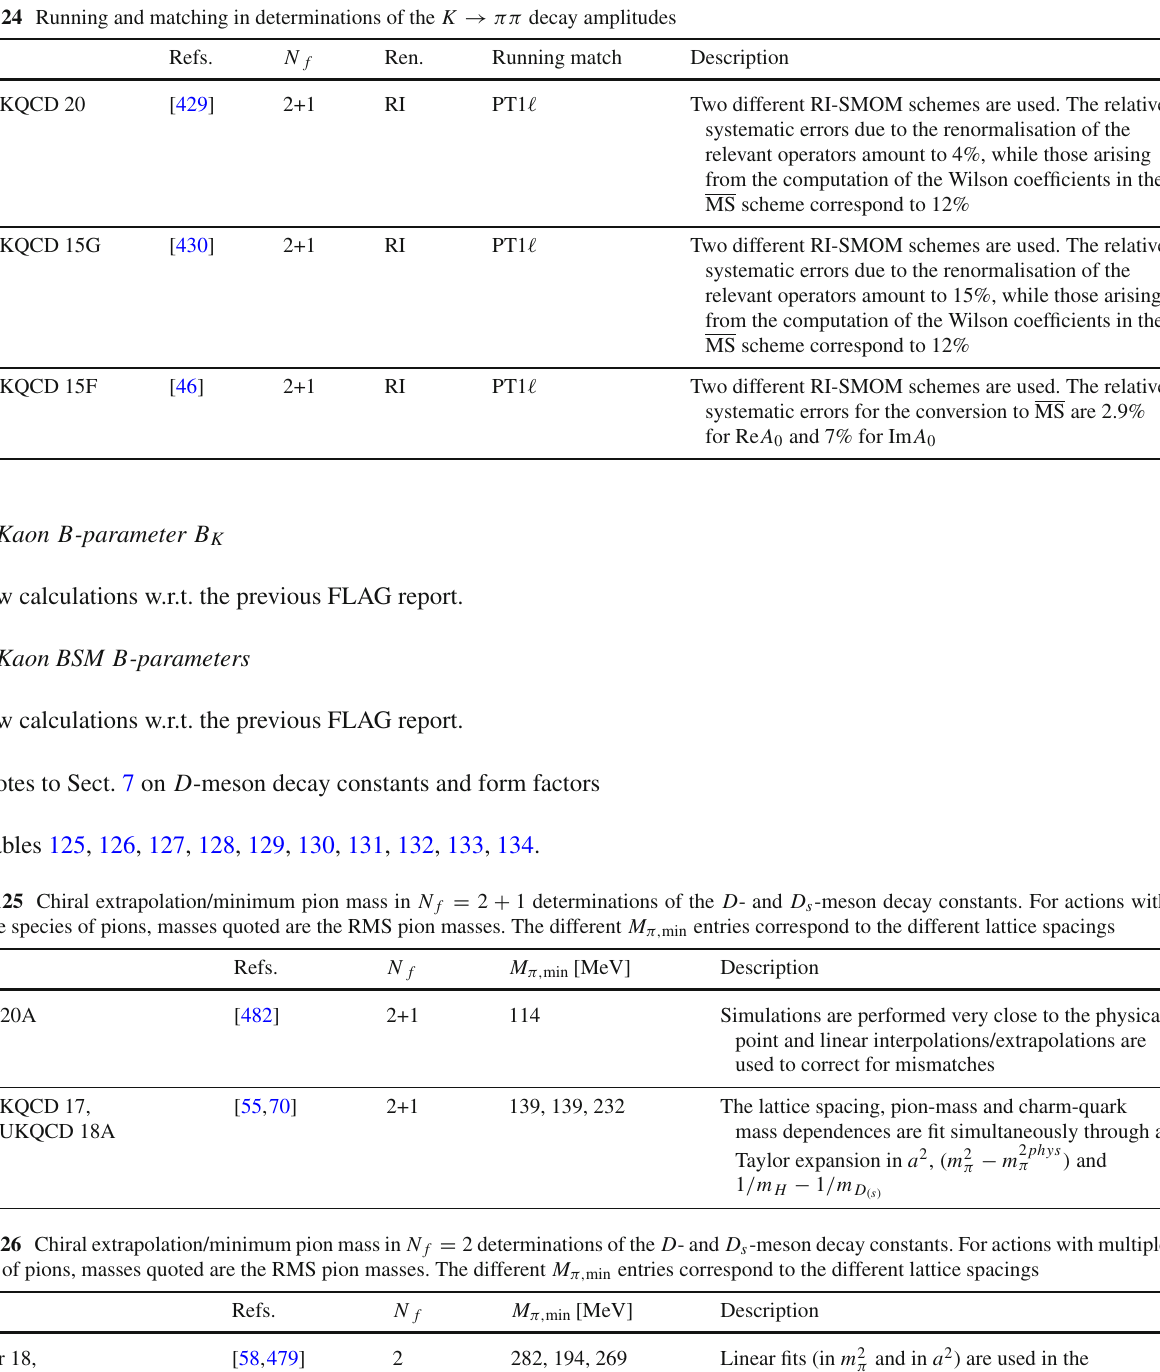
Linear fits (in m 2 π and in a 2 ) are used in the combined chiral/continuum extrapolation. NLO HM χ PT expressions are used for a cross-check, concluding however that there are not enough data points to be sensitive to the NLO